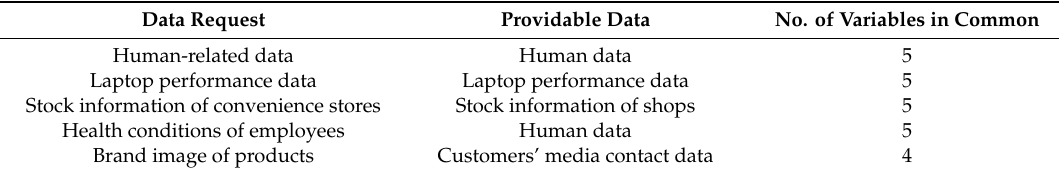
Table 3. Top five matched pairs.